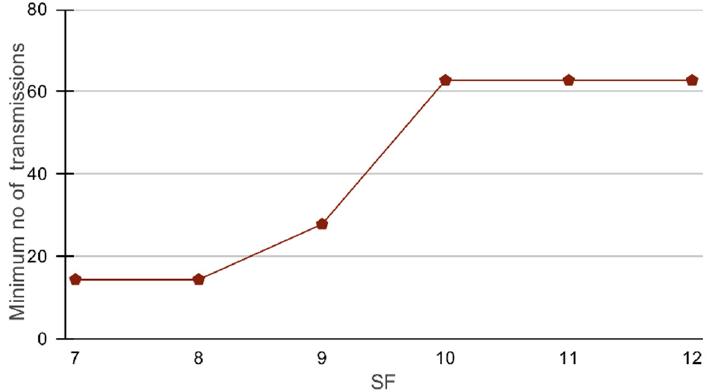
Figure 18. Minimum number of transmissions required per node for networks consisting of different Spreading Factors (SFs).